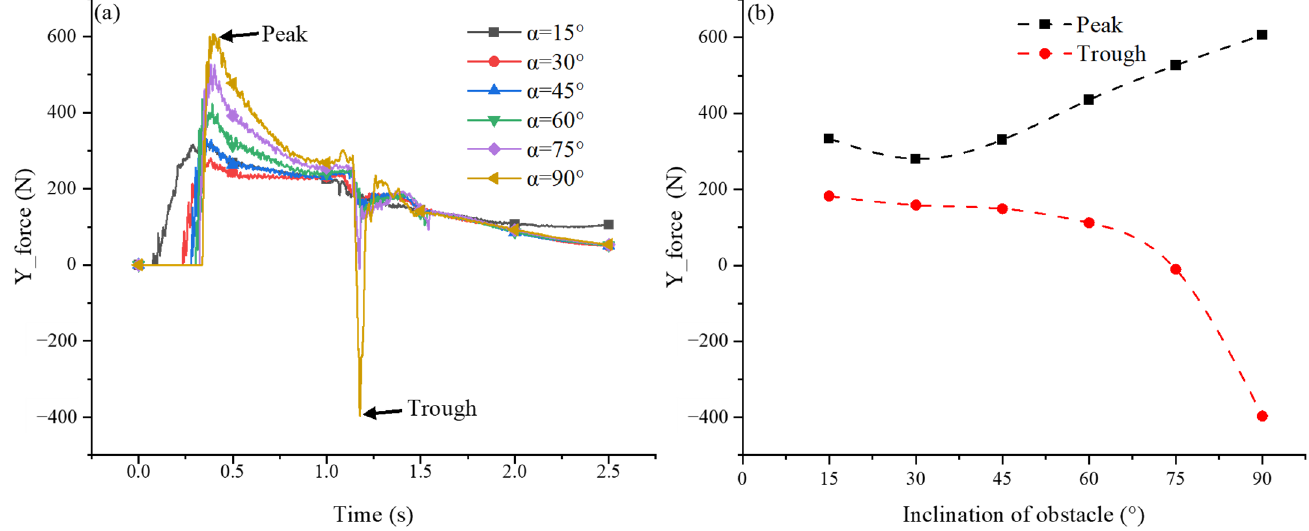
Figure 7. The Y force exerted on the obstacle along the Y direction: ( a ) time-history of Y force under different inclination angles of the obstacle; ( b ) peak and trough values of Y force as a function of upstream slope inclination angle of catch dam.